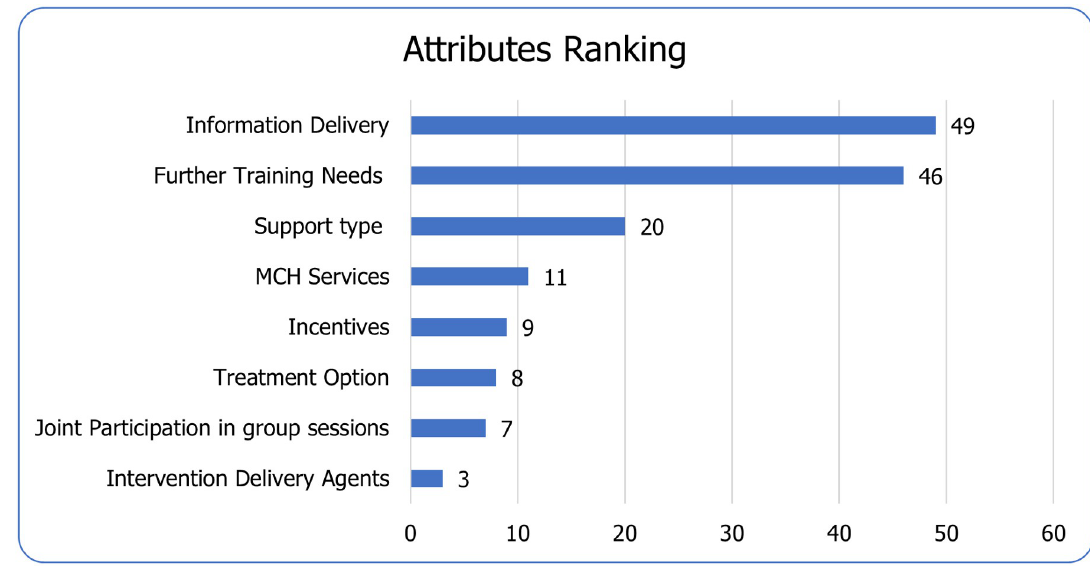
Fig 4. Ranking of